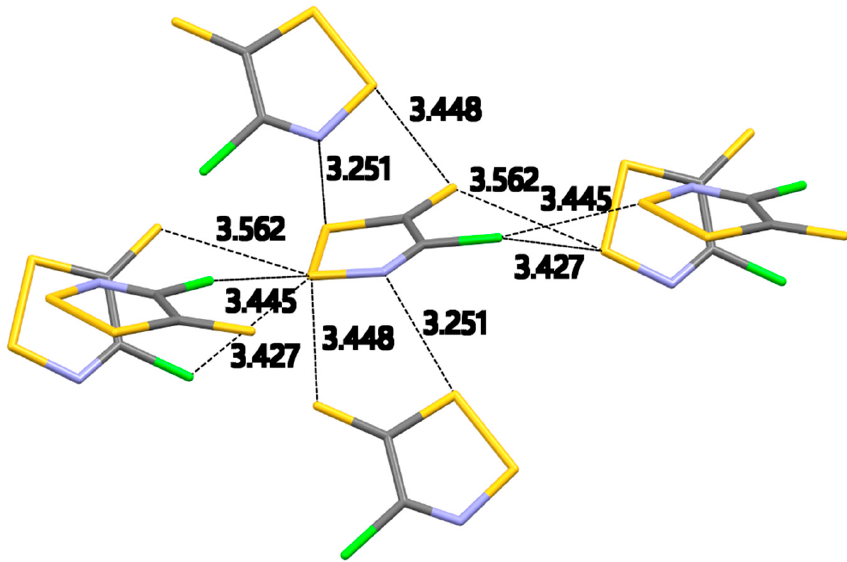
Figure 2. Intermolecular short contacts (Å) expanded for the central dithiazolethione 2c- α in the asymmetric unit cell.